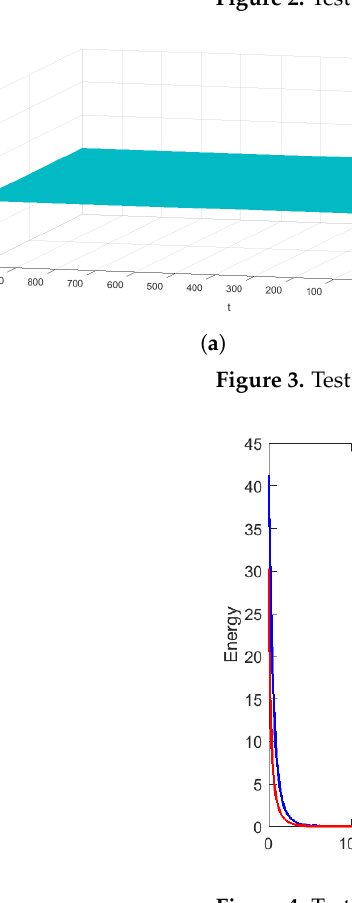
Figure 2. Test 1: energy decay.